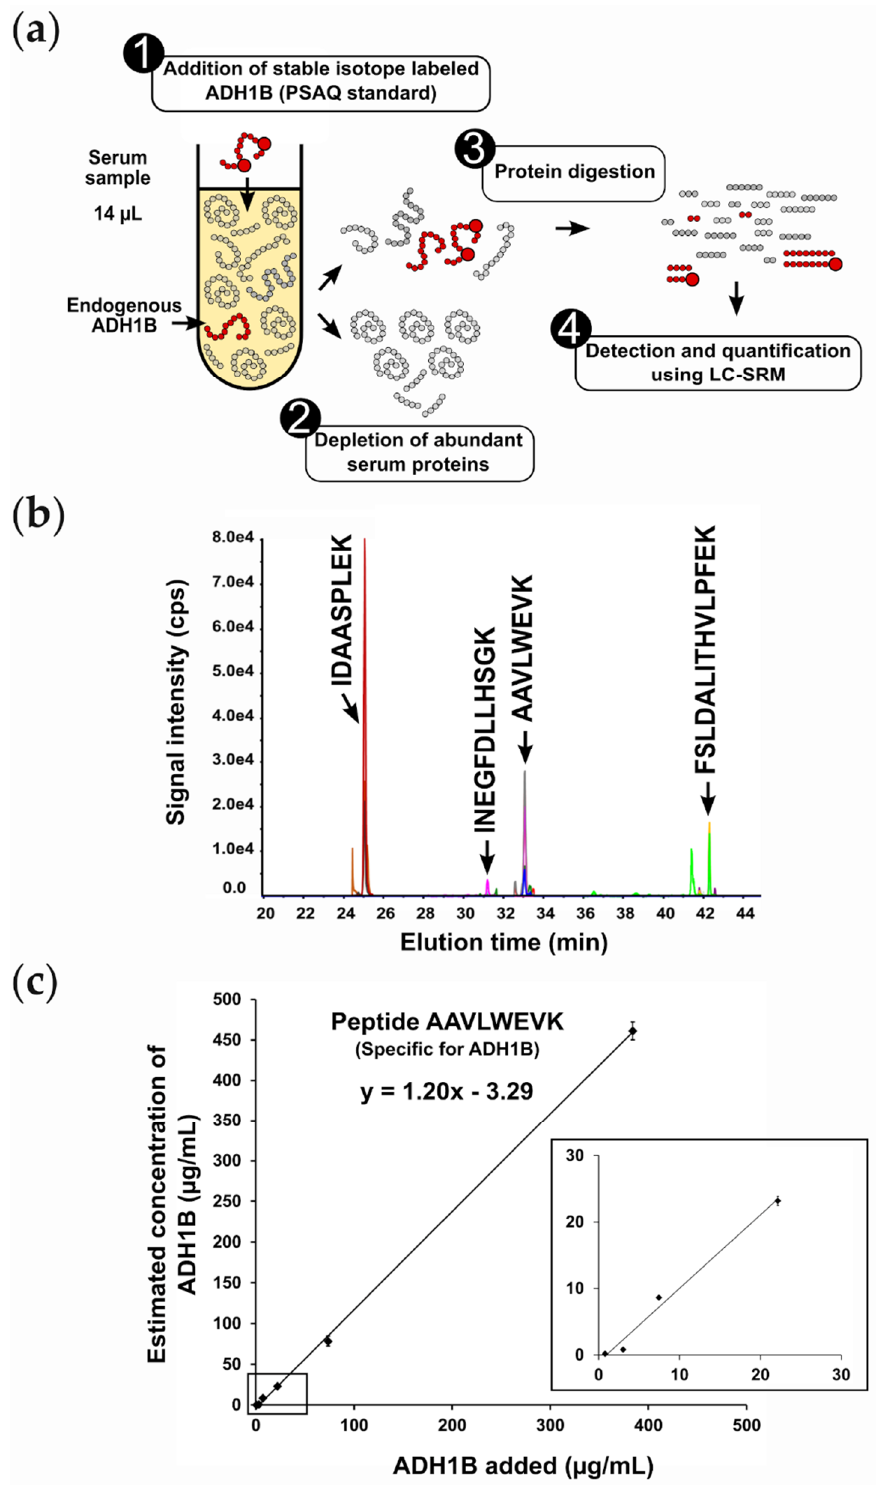
Figure 2. Targeted proteomics assay to quantify ADH1B in serum or plasma samples: ( a ) Different steps of the analytical workflow. ( b ) Extracted ion chromatogram obtained after serum depletion, digestion, and analysis by scheduled LC–SRM. Four peptides generated by ADH1B proteolysis were monitored. Only the specific peptide for ADH1B isoenzymes (peptide AAVLWEVK) was considered for ADH1B quantification. ( c ) ADH1B calibration curve.